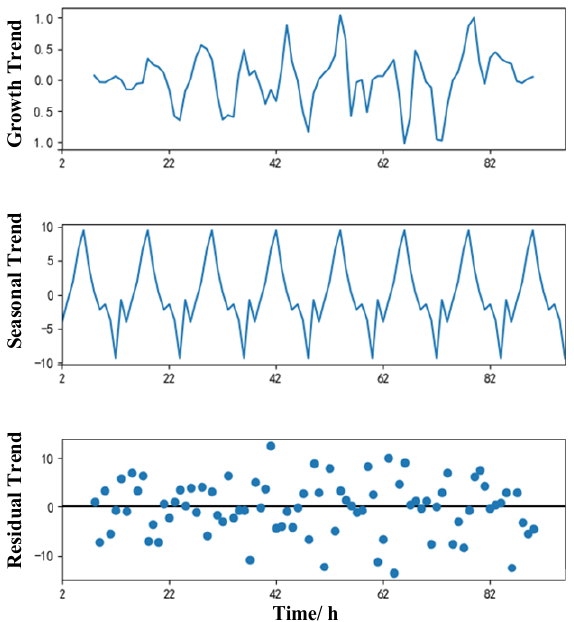
Figure 15. Analysis of offset distance trend.